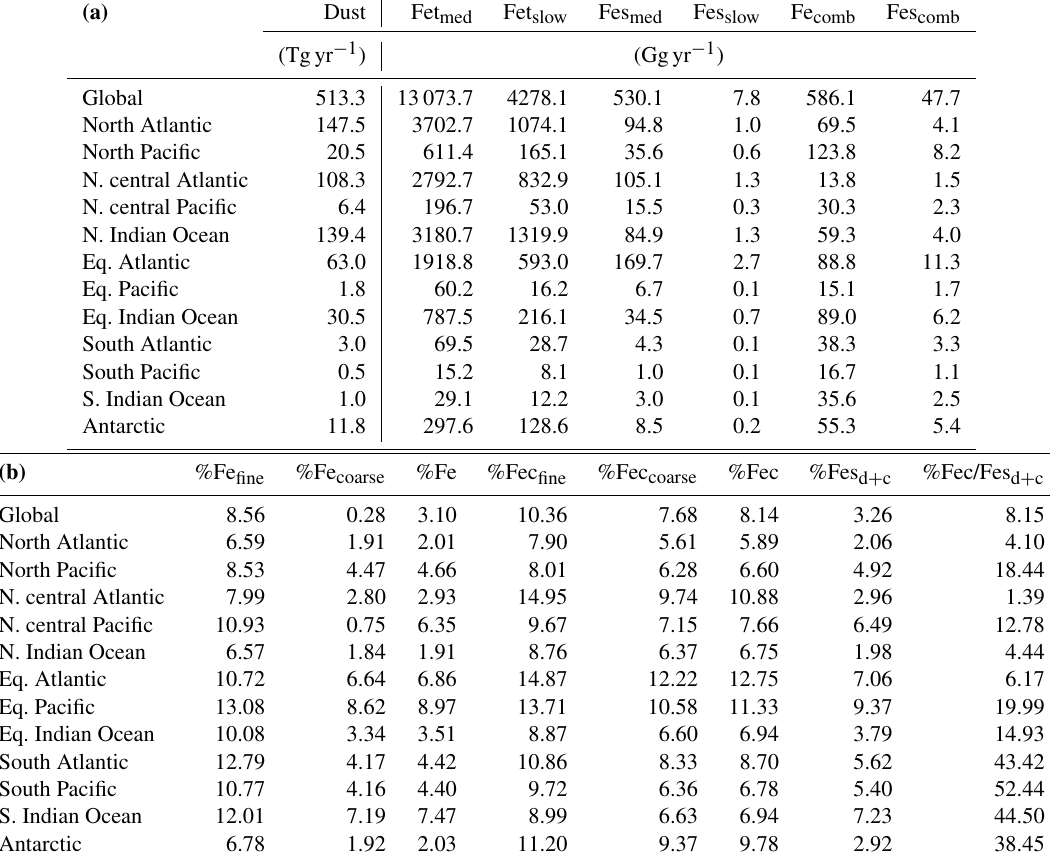
Table 5. (a) Global ocean and regional ocean basin total deposition for dust (Tgyr − 1 ), total iron from dust and combustion, labile iron in dust and combustion aerosols (Ggyr − 1 ). (b) Global ocean and regional ocean basin fractional iron solubility for fine, coarse and total dust and combustion iron, total fractional iron solubility from both dust and combustion, and the fraction of percent soluble combustion iron to total fractional iron